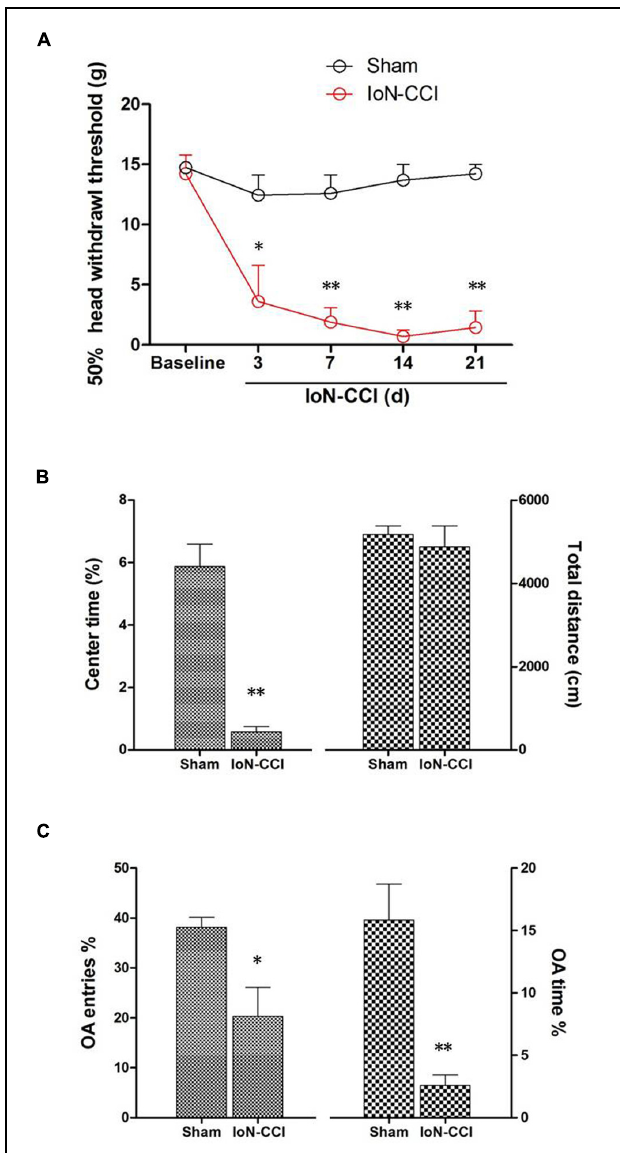
FIGURE 1 | Infraorbital nerve chronic constriction injury (IoN-CCI) produced significant nociceptive behaviors and negative emotions in rats. (A) The 50% HWT assessed by von Frey filaments after IoN-CCI and sham surgery ( n = 8/group); (B,C) IoN-CCI induced obvious negative emotions on day 14 after IoN-CCI surgery, as indicated by the open field (OF) (B) and EPM tests (C) . ( ∗ P < 0.05, ∗∗ P < 0.01 compared with the sham control at the same time